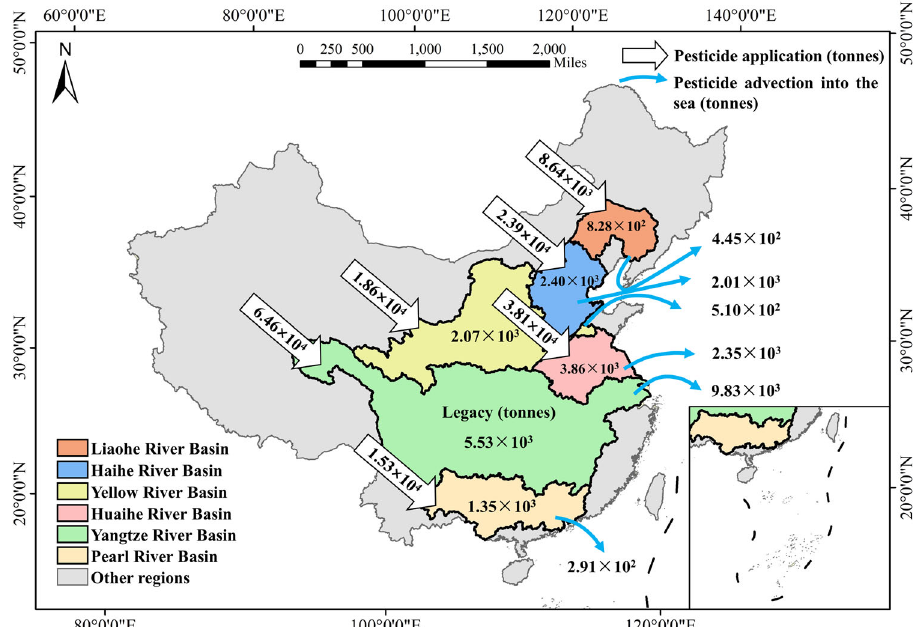
Fig. 2 Estimated pesticides usage, legacy and advection into seas for major river basins in a recent year. The number in each river basin represents the legacy in